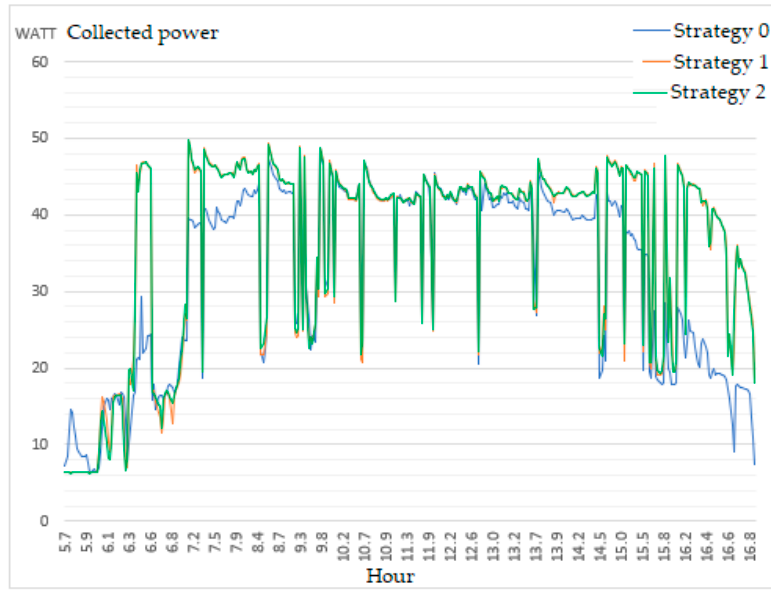
Figure 7. The power received by strategies 0, 1 and 2 for comparison.